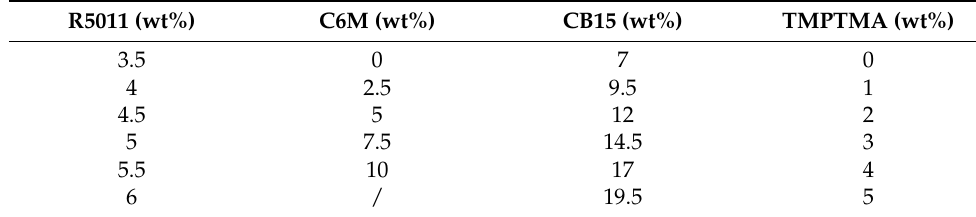
Table 1. Factor numbers and level numbers of experimental